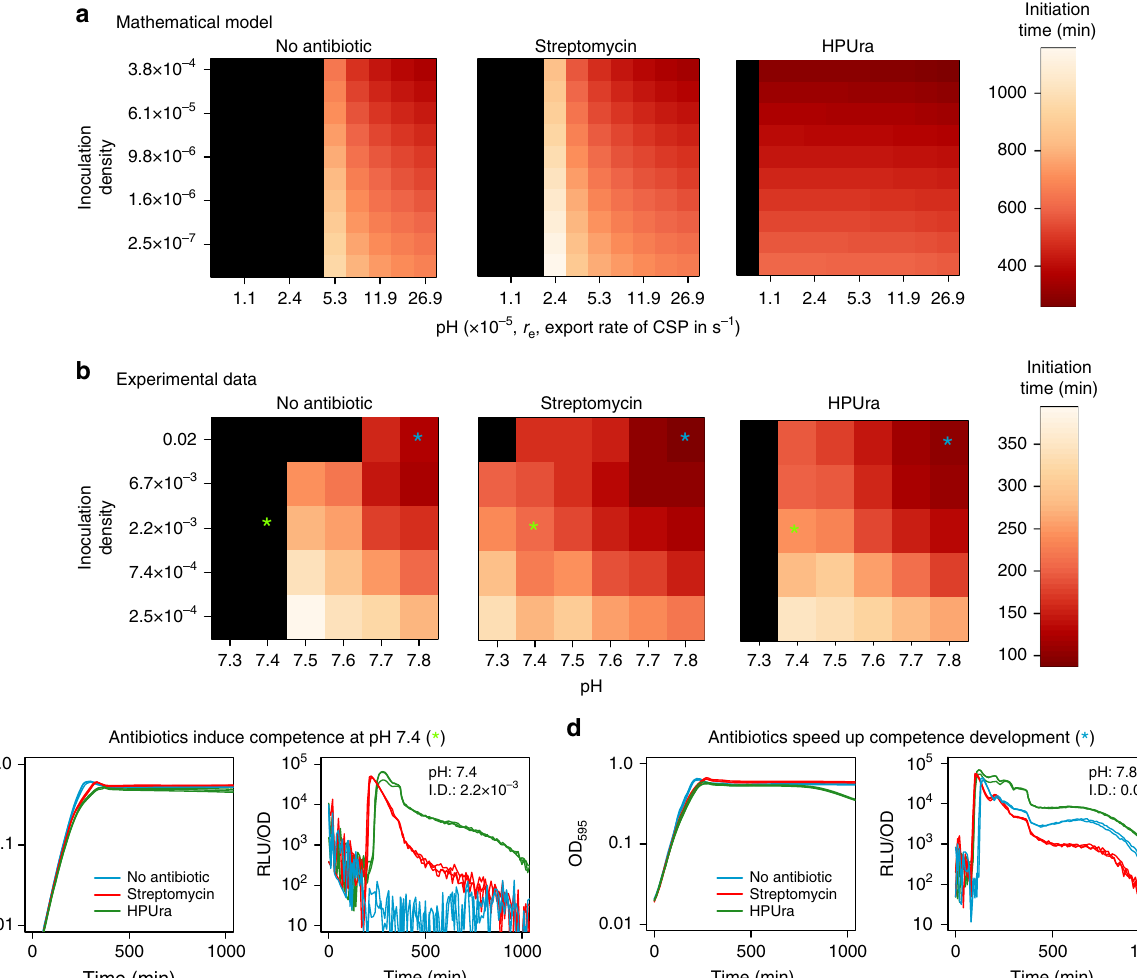
Fig. 5 Competence is simultaneously regulated by cell density, pH and antibiotic stress. a , b Predictions of the mathematical model ( a ) and experimental data ( b ) on the dependency of the time of competence initiation on inoculation density, initial pH, and antibiotic stress. The x -axis in a corresponds to the rate of CSP export in the model, r e , which is a proxy for pH. The color scales with the time of competence initiation with more intense red corresponding to faster development of competence. Black represents no competence development. In b , each box corresponds to the average initiation time of three replicates. Both the model and the experimental data show that competence develops faster at higher pH and higher inoculation densities. c Antibiotics induce competence at pH values that repress natural competence development. d At pH values that are not repressive for competence development (pH > 7.4), competence develops faster in the presence of antibiotics. The stars indicate which conditions are plotted in c and d . The concentrations of streptomycin and HPUra are 3 µ g mL − 1 and 0.075 µ g mL − 1 , respectively. We chose these sub-MIC concentrations to minimize the effect of antibiotic